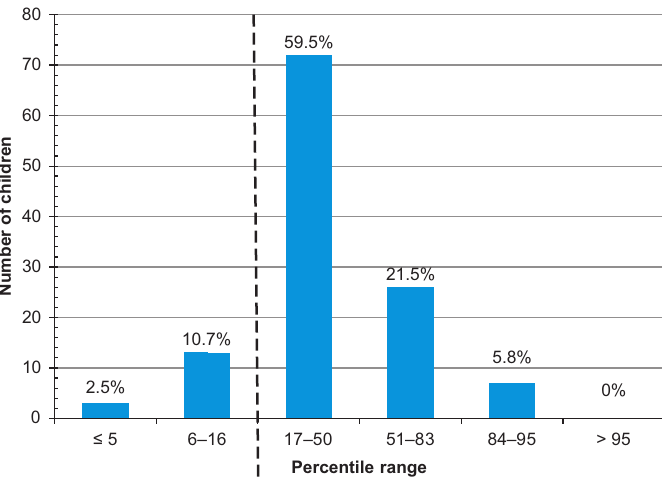
Figure 1. Total sample distribution according to MABC-2 test norms (≤ 5 th percentile = significant motor difficulties, 6–16 th percentile = risk of motor difficulties, > 16 th percentile = no mo- tor difficulties). The dashed line divides the children with and without any motor difficulties.